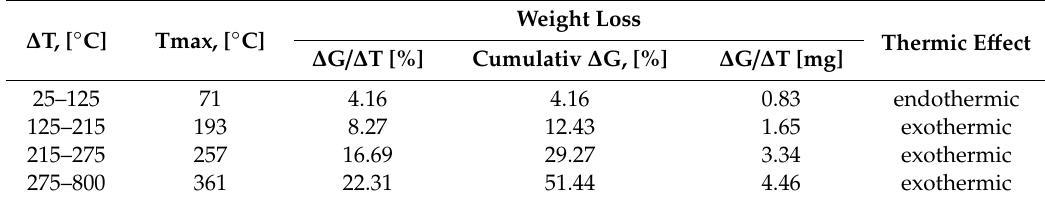
Table 2. Weight losses, thermal e ff ects and decomposition domains of the silica-iron oxide